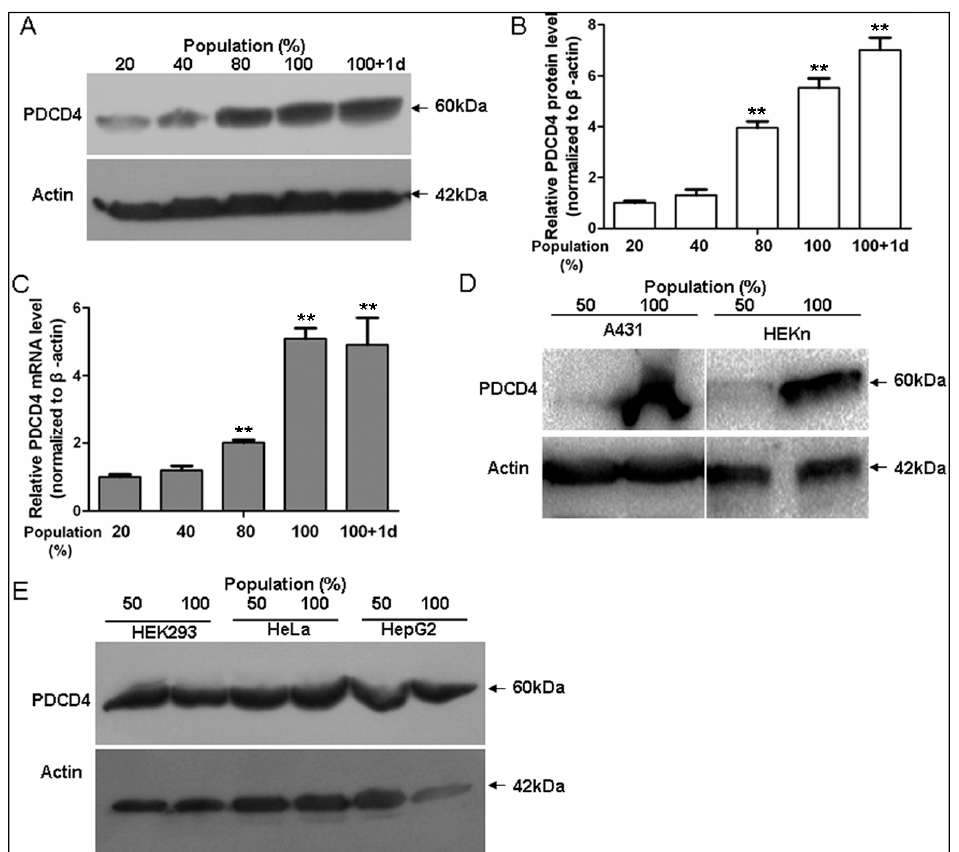
Figure 1. Upregulation of PDCD4 in human keratinocytes in a cell density-dependent manner. ( A ) Cell density-dependent expression of PDCD4 protein in human keratinocytes. HaCaT cells were cultured to reach the indicated cell densities. PDCD4 and β -actin expressions were analyzed by immunoblotting; ( B ) Densitometric analysis of PDCD4 expression at different cell densities. PDCD4 data were normalized to β -actin and plotted as means ± SD. The results shown are representative of three independent experiments; ( C ) Cell density-dependent expression of PDCD4 mRNA in HaCaT cells were determined by qRT-PCR ( n = 3); ( D ) Cell density-dependent expression of PDCD4 protein in A431 human squamous carcinoma and HEKn primary human neonatal epidermal keratinocytes; ( E ) PDCD4 expression in other human cells. In HEK293, HeLa and HepG2 cells cultured to reach the indicated cell densities, PDCD4 was analyzed by immunoblotting. d, day; **, p < 0.01, when vs. 20% cell population.